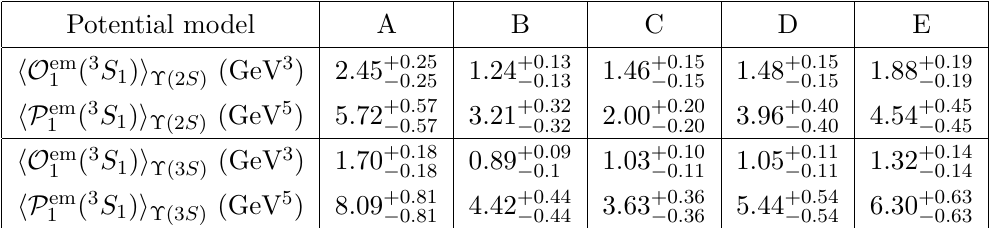
( 3 S 1 ) j (cid:7)( nS ) i and h (cid:7)( nS ) j P em ( 3 S 1 ) 1 1 ( 3 S 1 ) i and hP em ( 3 S 1 ) i for short. (cid:7)( nS ) (cid:7)( nS ) 1 1